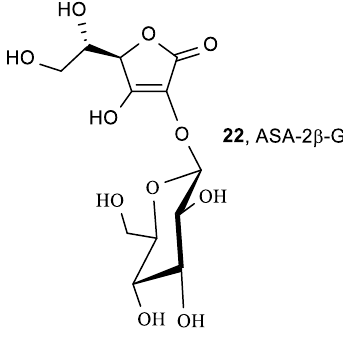
Figure 8. The pro-vitamin C derivative ASA-2 β -G.